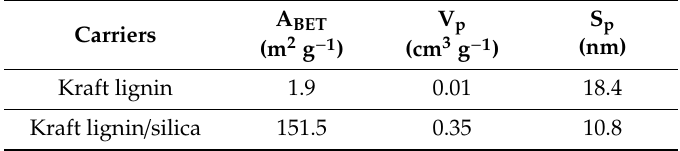
Table 2. Properties of the porous structure of kraft lignin [18] and the kraft lignin / silica system. A BET V p S p Carriers